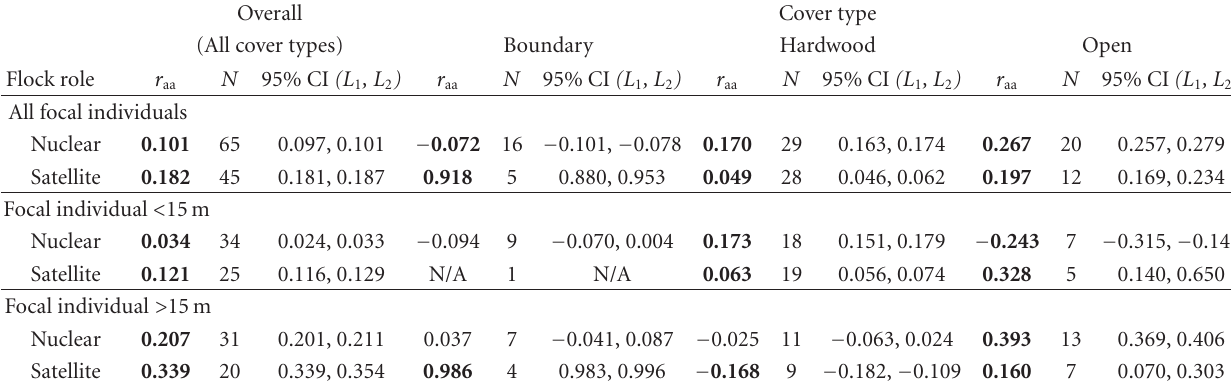
Table 2: Angular-Angular correlation coe ffi cients ( r aa ) for correlations between a focal individual’s movement direction and the movement direction of responding individuals (within-flock movement) in di ff erent cover types and for di ff erent movement distances of focal individuals. N = number of individuals observed. Confidence intervals (95% CI) for each r aa are reported ( L 1 , L 2 ; see Zar [35]). Confidence intervals that do not include 0 indicate a significant r aa (in bold print) at P <